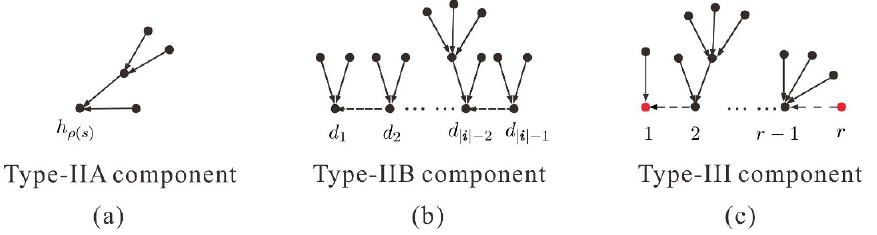
Figure 16 . The component involving the highest-weight element H is de(cid:12)ned as (a). the type- (cid:26) ( l ) IIA component if H is a graviton h , (b). the type-IIB component if H is a gluon trace (cid:26) ( l ) (cid:26) ( s ) (cid:26) ( l ) ttt ! f d 111 = f 1 ; 2 ; : : : ; r (cid:0) 1 ; r g , as shown by the 1 ; : : : ; d j ttt j(cid:0) 1 g . The component containing the trace graph (c), is de(cid:12)ned as the type-III